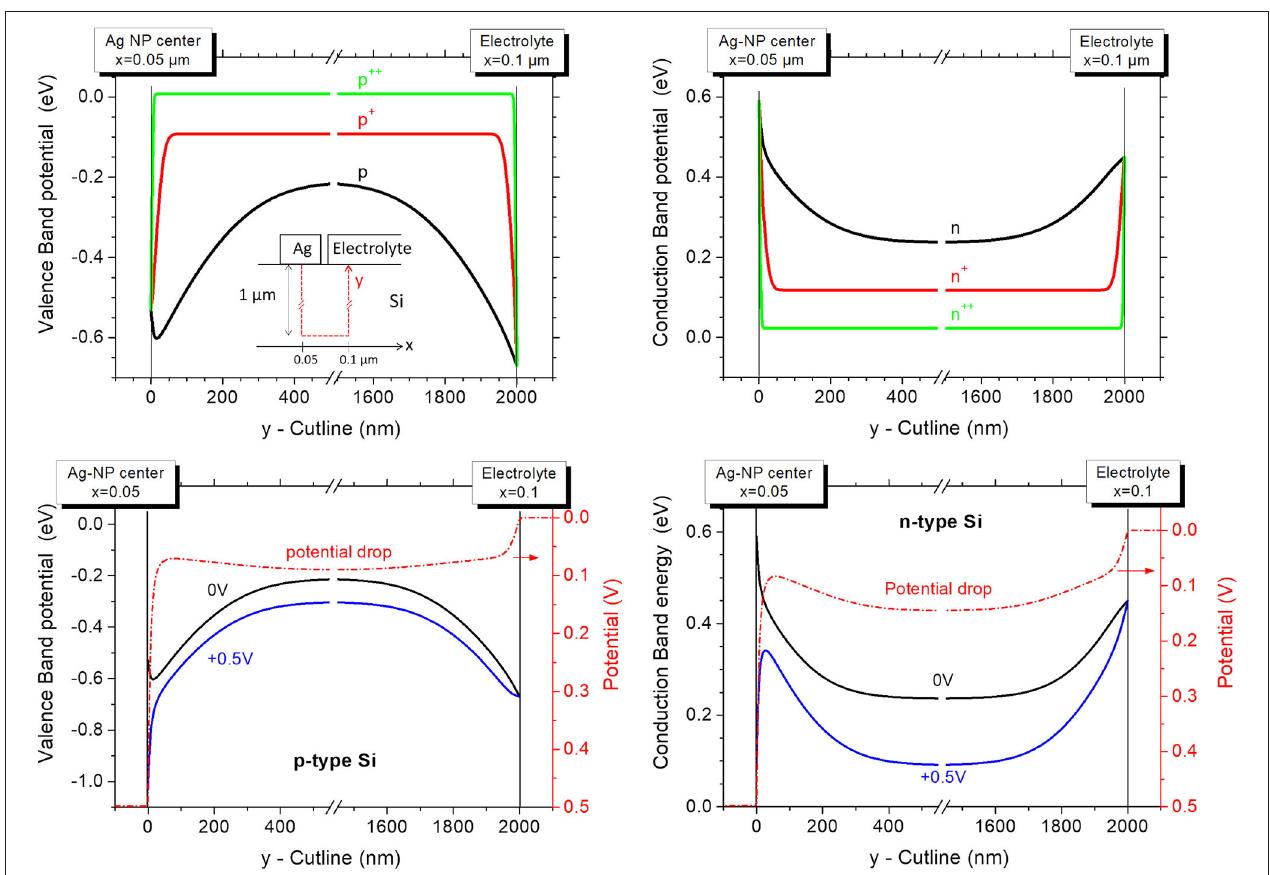
FIGURE 3 | Band diagram (valence band and conduction band for p-type and n-type silicon, respectively) of the modeled Ag/Si/electrolyte (HF) system at equilibrium (top row) and under a positive polarization of silver vs. Electrolyte by + 0.5V (bottom row). x is the lateral position at the surface of the device and y the position along the cutline through bulk Si, as schematized in the upper-left band diagram and in Figure B of the Supplementary Information. Three doping levels for n and p-type silicon are represented (right and left column, respectively). The spatial distribution of the voltage drop is also presented (red dash-dot line).